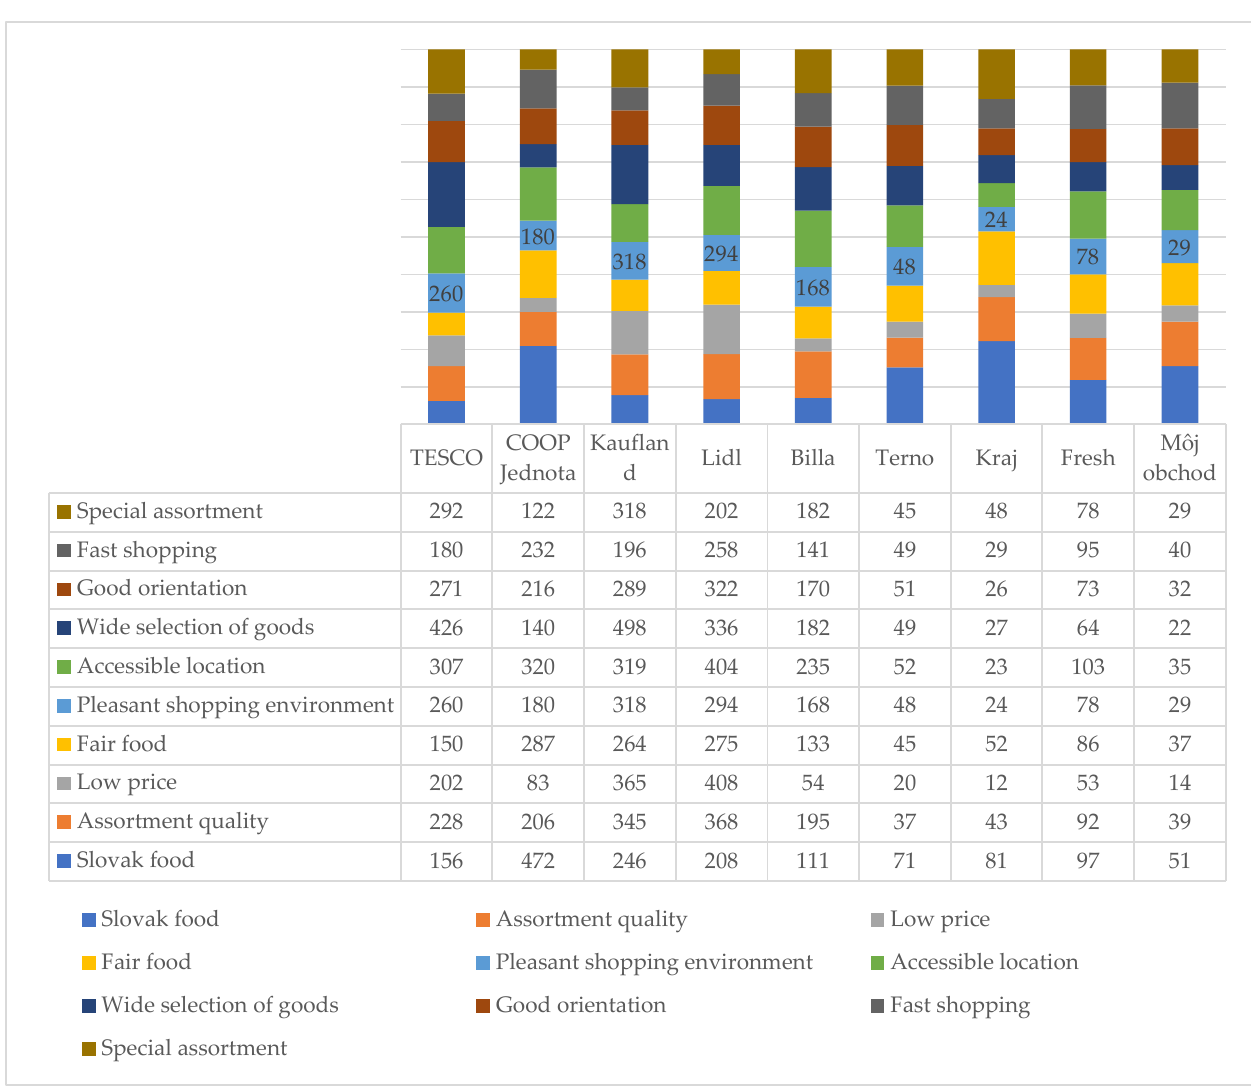
Figure 4. Perception of sellers’ characteristics.